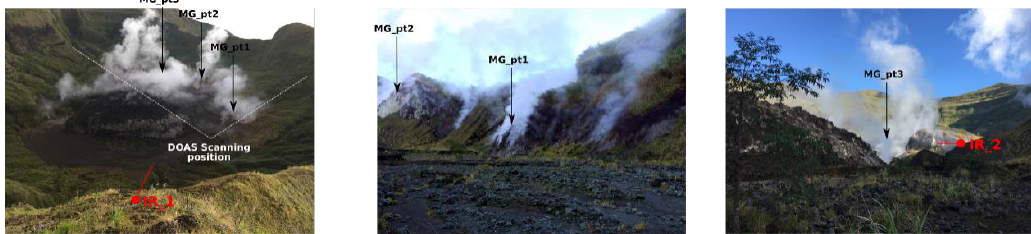
Figure 2. Awu crater hosts a cooling lava dome ( left picture) of 30 m height and 200 m in diameter, surrounded by numerous fumaroles. The MultiGAS was deployed at 3 different locations, namely MG_pt1, MG_pt2, and MG_pt3 ( left and central pictures). The strongest degassing site (MG_pt3) is located in the northern part of the crater ( right picture). The position of the thermal camera is provided on the left and right pictures.